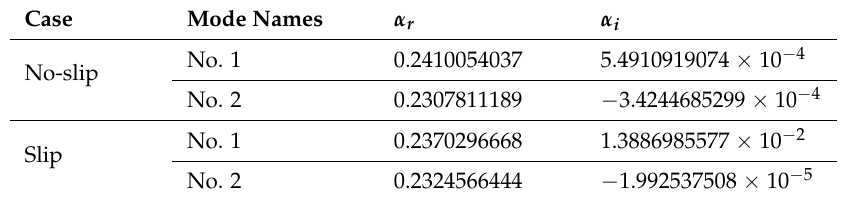
Figure 3. Selected eigenvectors for the stable (Mode No. 1) and the unstable modes (Mode No. 2) for no-slip flow. Ma e = 4.5, x ∗ = 0.139 m, and R = 1000.152. ( a ) ˆ u ; ( b ) ˆ v ; ( c ) ˆ p ; ( d ) ˆ T . Table 2. Discrete Modes of B.L. flow with and without Slip B.C.s, Ma = 4.5, R = 1000.152, Ω = 2.2 × 10 − 4 , and x = 0.1393